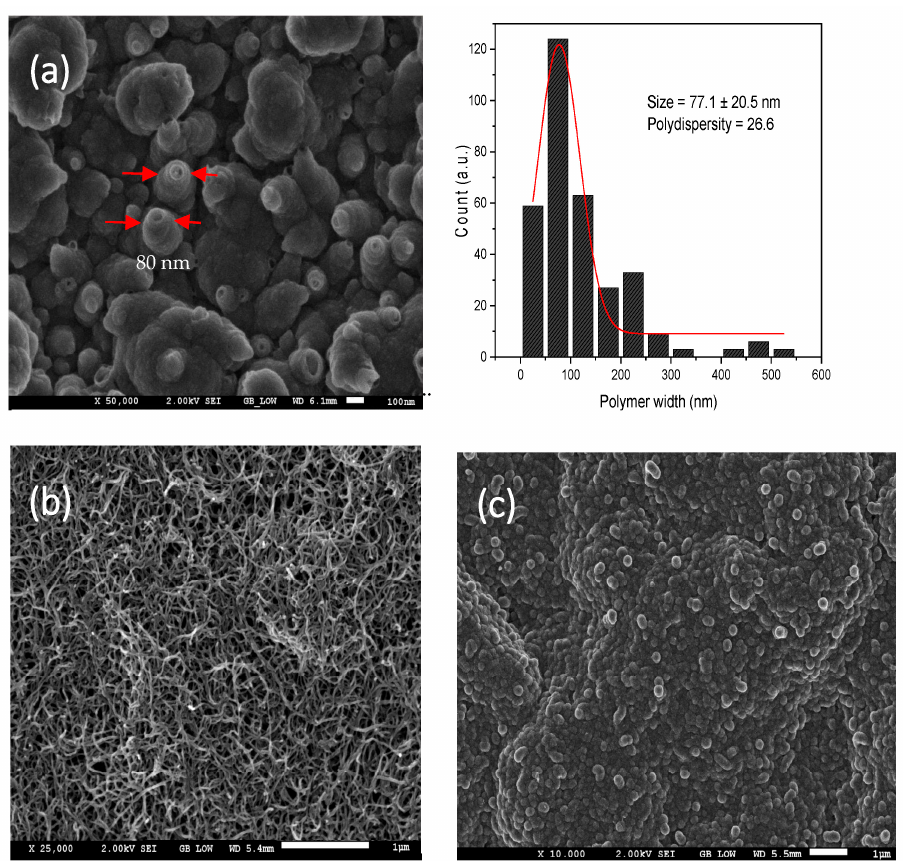
Figure 7. SEM characterization of MIP/GCE ( a ), MWCNT/GCE ( b ), and MIP/MWCNT/GCE ( c